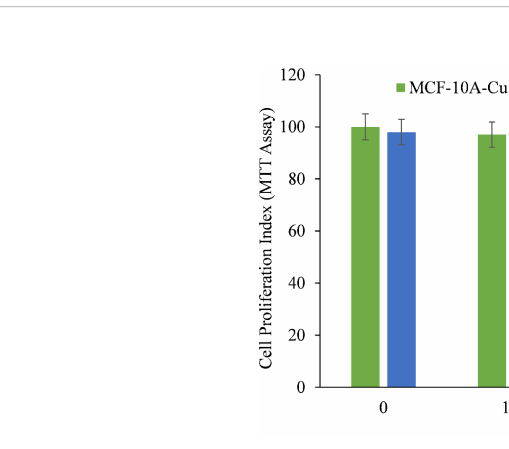
FIGURE 9 The effect of delphinidin on the elevated mRNA transcript levels of copper transporters Ctr1 and ATP7A in MCF-10A-Cu cells compared to their parental MCF-10A cells. TRIzol (Invitrogen) was used to isolate total RNA in accordance with the manufacturer ’ s instructions. As described in “ Methods, ” Ctr1 and ATP7A mRNA expression was quanti fi ed using real-time PCR. To determine the effect of delphinidin on mRNA expression, only MCF-10A-Cu cells (normal MCF-10A cells cultured in a medium containing 25 µM CuCl2) with enhanced mRNA expression of copper transporters were treated with 50 µM delphinidin. The values reported are the S.E. of three separate trials. p ≤ 0.01 when compared to respective untreated control was treated as signi fi